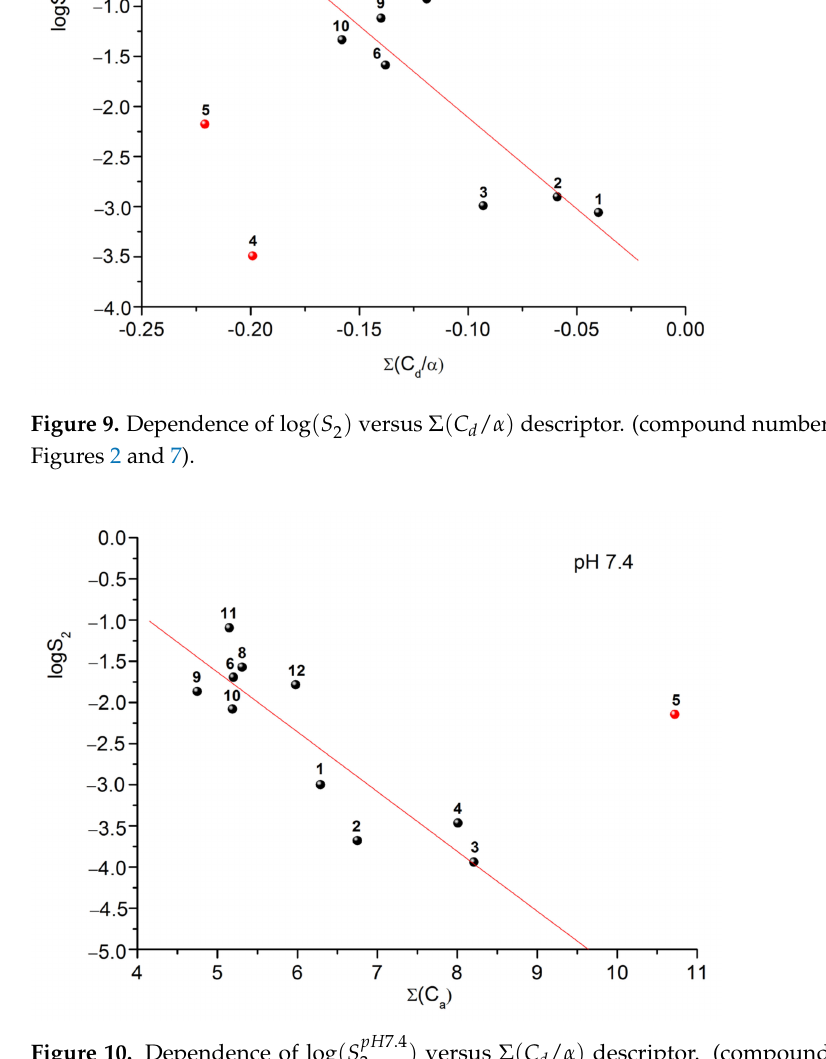
Figure 10. Dependence of log ( S pH 7.4 sponds to Figures 2 and